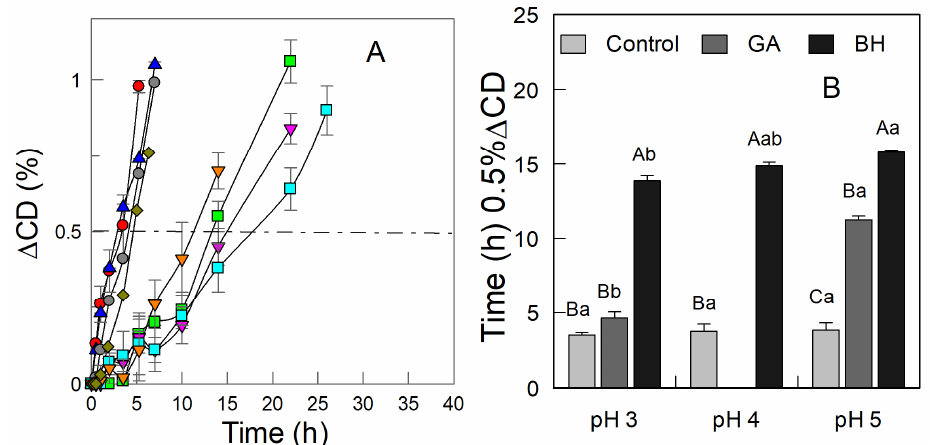
Figure 3. ( A ) Oxidative stability in terms of the variation in CDs formation of 4:6 (O / W) stripped fish Figure 3. (A) Oxidative stability in terms of the variation in CDs formation of 4:6 (O/W) stripped fish oil-in-water emulsions containing BH Bryophyllum extracts (TPC 400 µ M GAE) and GA (500 µ M) at oil-in-water emulsions containing BH Bryophyllum extracts (TPC 400  M GAE) and GA (500  M) at di ff erent acidities of aqueous region and at T = 25 ◦ C ( Φ I = 6.68%). The control samples did not contain different acidities of aqueous region and at T = 25 °C (  I = 6.68%). The control samples did not contain any antioxidant ( • - control pH = 3, (cid:78) - control pH = 4, • - control pH = 5, (cid:72) - GA pH = 5, (cid:7) - GA pH = 3, any antioxidant (  - control pH = 3,  - control pH = 4,  - control pH = 5,  - GA pH = 5,  - GA pH (cid:4) - BH pH = 3, (cid:72) - BH pH = 4, (cid:4) - BH pH = 5). The dashed line marks the hours required for a 0.5% =3,  - BH pH = 3,  - BH pH = 4,  - BH pH = 5). The dashed line marks the hours required for a 0.5% increase in CDs. ( B ) E ff ect of the acidity of aqueous region of 4:6 (O / W) emulsions containing BH increase in CDs. (B) Effect of the acidity of aqueous region of 4:6 (O/W) emulsions containing BH Bryophyllum extracts on the time needed to reach 0.5% ∆ CD. Data were expressed as average ± standard Bryophyllum extracts on the time needed to reach 0.5%  CD. Data were expressed as average ± deviation. Di ff erent lower-case letters indicate significant di ff erences between the same treatments standard deviation. Different lower-case letters indicate significant differences between the same at di ff erent pH values and di ff erent capital letters indicate significant di ff erences between di ff erent treatments at different pH values and different capital letters indicate significant differences between treatments within the same pH values ( α = different treatments within the same pH values (  = 0.001).